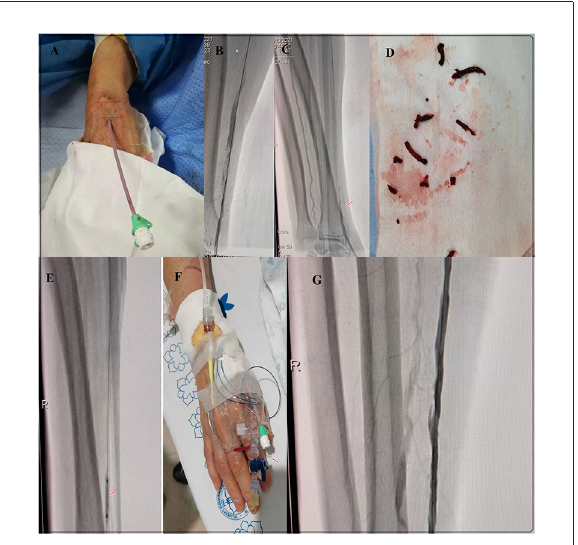
FIGURE1 Radial artery recannulation of RAO. (A) Insertion of the 6 French introducer sheath via snuffbox with ∼ 1–2cm depth. (B,C) Radial angiography to determine the anatomy of the radial artery, the occluded end, thrombotic load, and the collaterals. (B) Acute occlusion. (C) Chronic occlusion. (D) Aspiration of the thrombus directly through the introducer sheath or aspiration catheter for acute occlusion or chronic occlusion with high thrombotic load. (E) Balloon angioplasty of the RAO. (F) Thrombolytic therapy with urokinase via finecross microcatheter (Terumo, Japan). (G) Final result of the radial angiography.